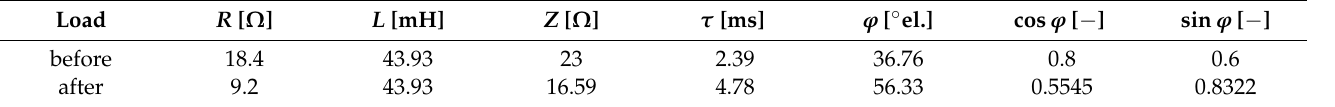
Table 8: Table 8. Load parameters for steady states before and after load change. Table 8. Load parameters for steady states before and after load change.